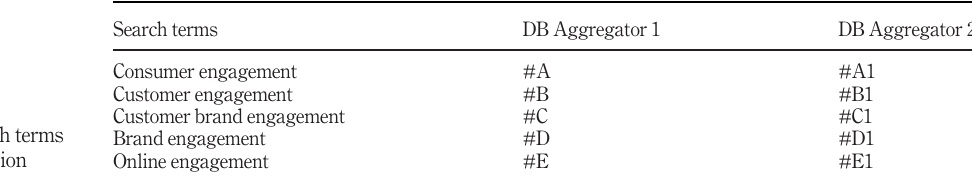
Table 1. SLR search